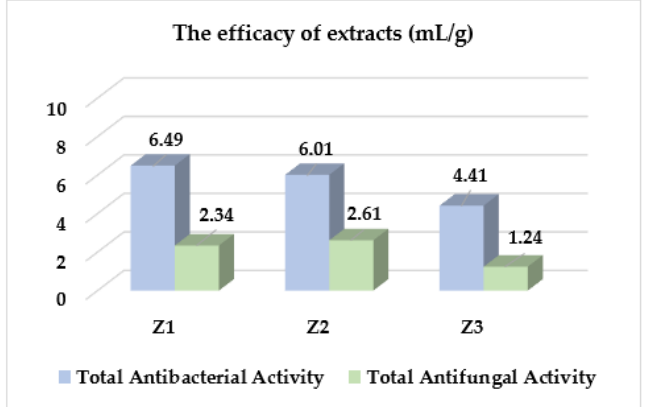
Figure 3. The efficacy (mean TAA values, mL/g) of Z. bungeana extracts against all the studied ref- erence bacteria and fungi. reference bacteria and